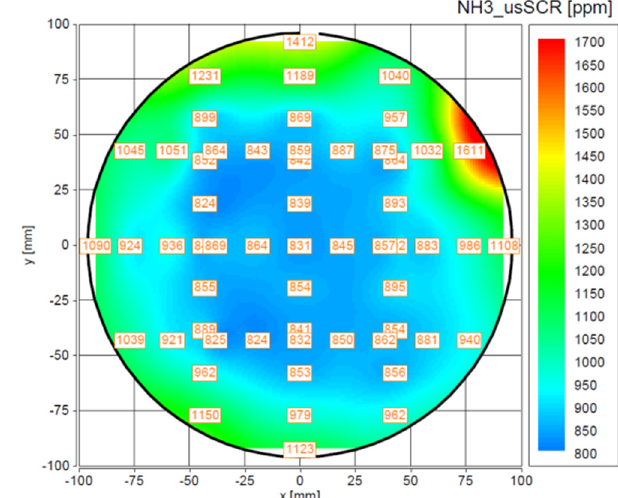
Fig. 15. Test points of ammonia uniformity.